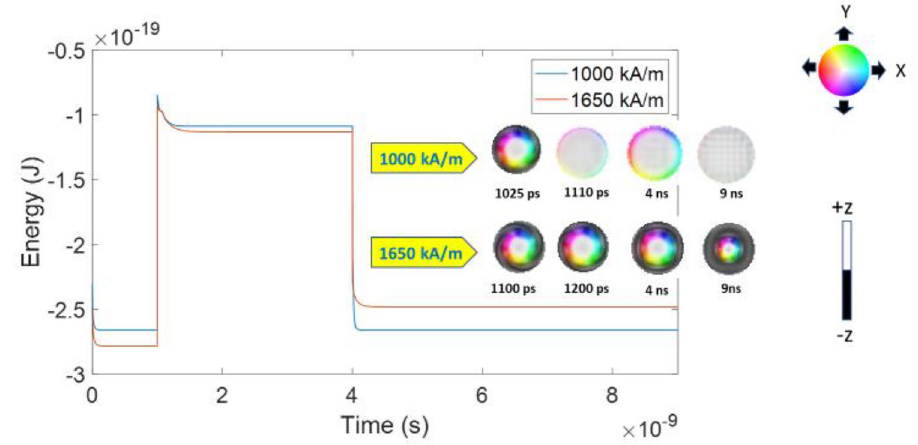
Figure 3. Evolution of total energy for two different M s values and their corresponding magnetic states at different times.